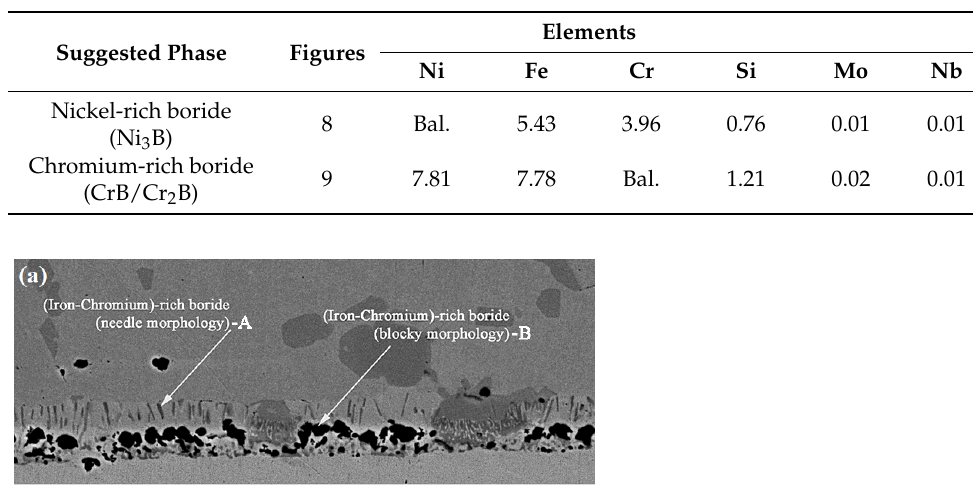
Table 5. EDX analysis of various phases indicated in Figure 9 (wt.%).